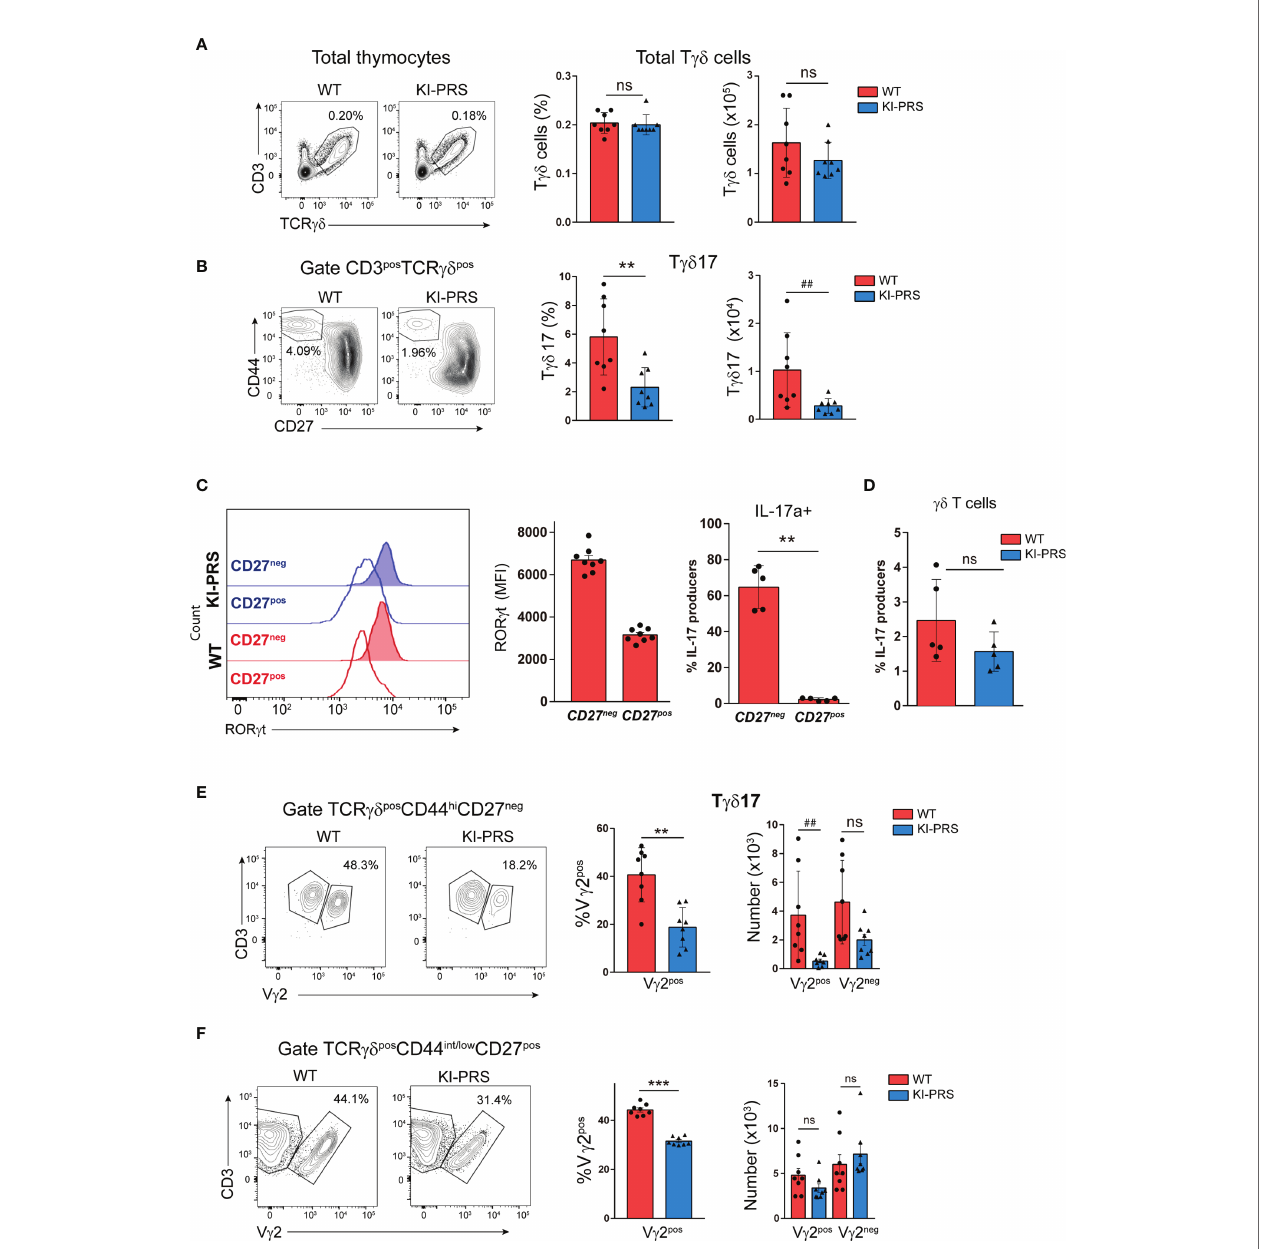
FIGURE 1 | Mutations in the polyproline sequence of CD3 e impair T gd 17 commitment in the thymus. Thymuses from 8-week old KI-PRS and wild-type (WT) littermates were harvested and processed for fl ow cytometry analysis of T gd cell subsets. (A) Representative dot plots show CD3 and TCR gd expression in total thymocytes. Graphs represent the frequency ( left graph ) and absolute cell number ( right graph ) of total T gd cells gated as CD3 pos TCR gd pos . (B) Representative dot plots of CD44 and CD27 expression among T gd cells. Graphs represent the frequency ( left , **p-value= 0.0047) and absolute cell number ( right , ## p-value= 0.0070) of T gd 17 cells, gated as CD3 pos TCR gd pos CD44 hi CD27 neg . (C) Representative histograms show the expression of the transcription factor ROR g t among T gd pos CD44 hi CD27 neg cells (T gd 17) and T gd pos CD44 int/low CD27 pos cell (uncommitted T gd ). Graph represents the mean of fl uorescence intensity (MFI) of ROR g t among the indicated populations. Analysis of IL-17A production. Total thymocyte suspensions were stimulated with PDBu/Io for 6h in presence of Golgi-Plug, and IL-17A production was determined by fl ow cytometry. Graph represents the frequency of IL-17A-producers among CD44 hi CD27 neg and CD44 int/low CD27 pos T gd cells. (D) Frequency of gd T cells IL17a producers. (E) Representative dot plots show V g 2 expression among T gd 17 cells (gated as TCR gd pos CD44 hi CD27 neg ). Graphs represent the frequency ( left , **p-value= 0.0019) and absolute cell number ( right , ## p-value= 0.0019) of V g 2 pos and V g 2 neg cells among T gd 17 cells. (F) Representative dot plots show V g 2 expression among uncommitted T gd cells (gated as TCR gd pos CD44 int/low CD27 pos ). Graphs represent the frequency ( left , ***p-value= 0.0002) and absolute cell number ( right ) of V g 2 pos and V g 2 neg cells among uncommitted T gd cells. The inset numbers in representative dot plots represent the percentage of cells within the indicated gate. All graphs represent mean ± sd of n=7-8 mice of each genotype. Statistical analysis was performed using Mann-Whitney t-test. ns, non signi fi cant. Data are representative of 2 independent